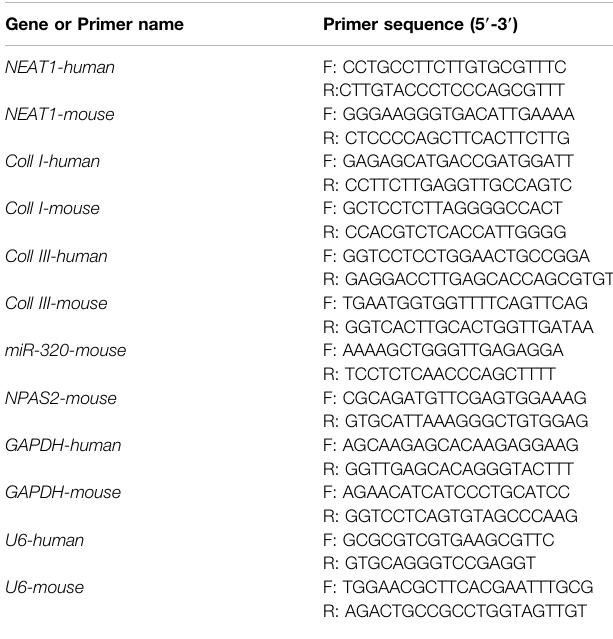
TABLE 1 | Primers used for qRT –